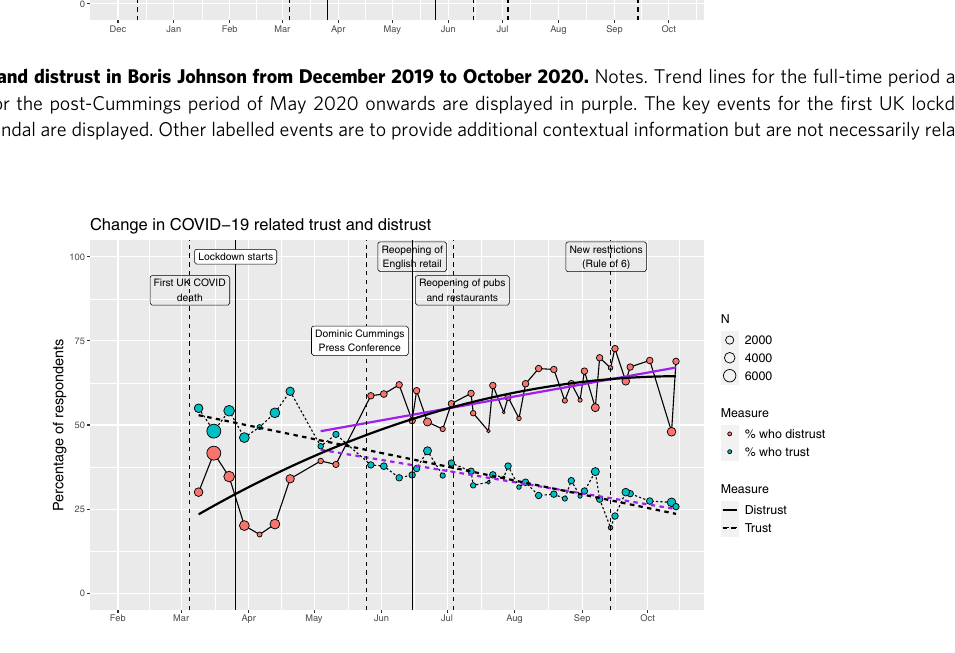
Fig. 3 Change in COVID-19 related trust and distrust from March to October 2020. Notes. Trend lines for the full-time period are displayed in black and trend lines for the post-Cummings period of May 2020 onwards are displayed in purple. The key events for the fi rst UK lockdown and the Dominic Cummings scandal are displayed. Other labelled events are to provide additional contextual information but are not necessarily related to changes in